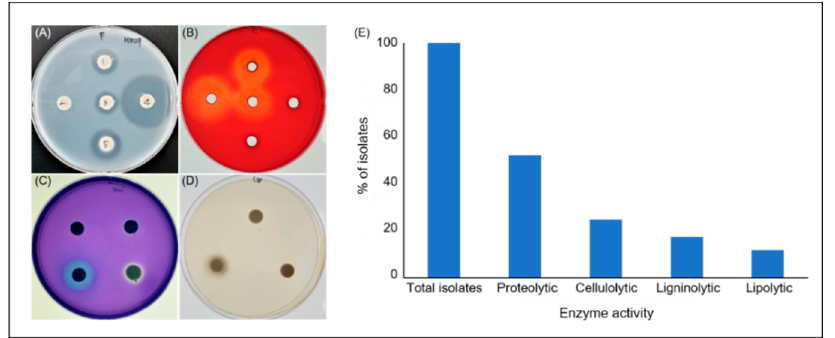
Figure 2. Production of extracellular lytic enzymes by the bacteria from FPWs. Plate assay show- ing ( A ) proteolytic, ( B ) cellulolytic, ( C ) ligninolytic, and ( D ) lipolytic enzyme activities of the isolated bacteria. The assay was performed by inoculation of the bacterial isolates on agar media containing suitable substrates specific for each enzyme activity. After incubation, media were treated with specific staining solutions to visualize the formation of clear halos around bacterial colonies, indicating production of the respective enzymes (representative plates showed). ( E ) Distribution (%) of extracellular hydrolytic enzyme activities among the isolates.